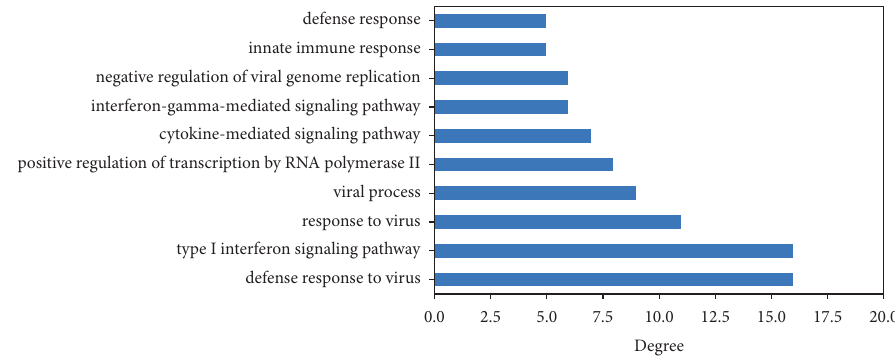
Figure 7: The highest degree of biological process with important